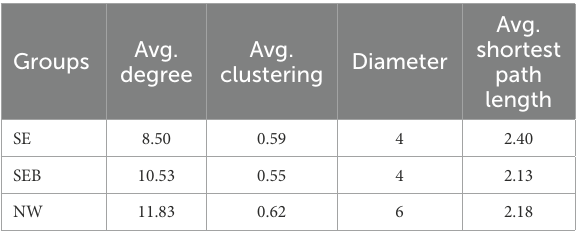
TABLE 3 The network parameters of three treatment groups.